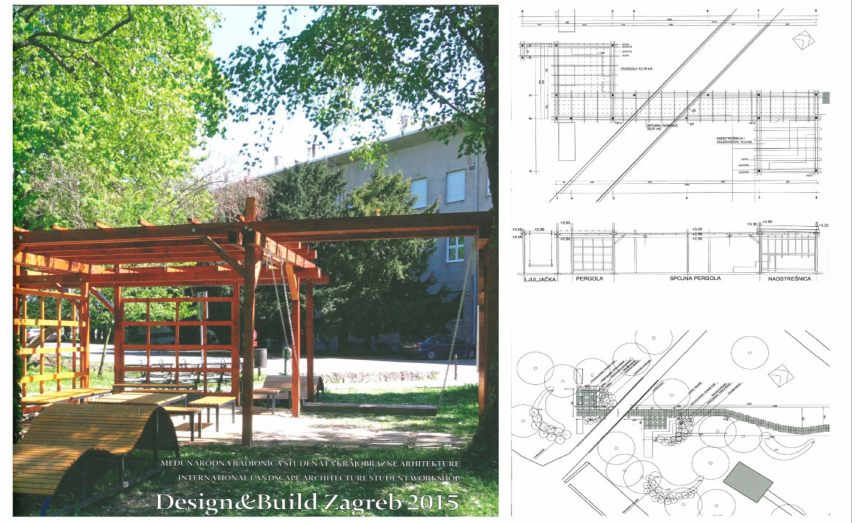
Figure 15. Design and Build at the Department of landscape architecture in Zagreb. In the upper right a technical drawing, in the lower right the plantation plan